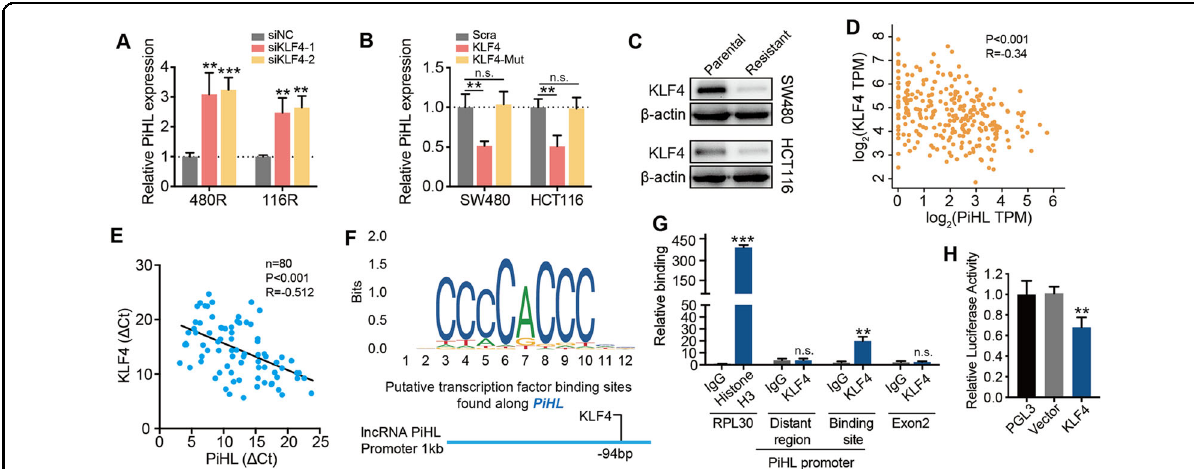
Fig. 2 PiHL is transcriptionally regulated by KLF4. A Levels of PiHL in KLF4 silencing Oxa-resistant cells were analyzed by qRT-PCR. B Levels of PiHL in KLF4 overexpression and DNA binding domain truncated KLF4 mutant (KLF4-Mut) overexpression CRC cells were analyzed by qRT-PCR. C Immunoblots showed KLF4 protein levels in parental and oxaliplatin-resistant CRC cells. D Correlation between KLF4 and PiHL was generated from GEPIA. n = 275 CRC tissues in COAD, Pearson correlation. E Correlation between KLF4 and PiHL from our CRC cohort. n = 80, Pearson correlation. F The transcriptional factor KLF4-binding motif was predicted by informatics analysis (top), schematic illustration of PiHL promoter with one potential KLF4-binding site (bottom). G ChIP-qPCR assay demonstrated the direct binding of KLF4 to PiHL promoter in SW480 cells. H Luciferase activity of PiHL promoter constructs after the transfection of the KLF4 plasmid in 293T cells. Student ’ s t -test, Signi fi cant results were presented as n.s. (non-signi fi cant), * P < 0.05, ** P < 0.01, *** P <